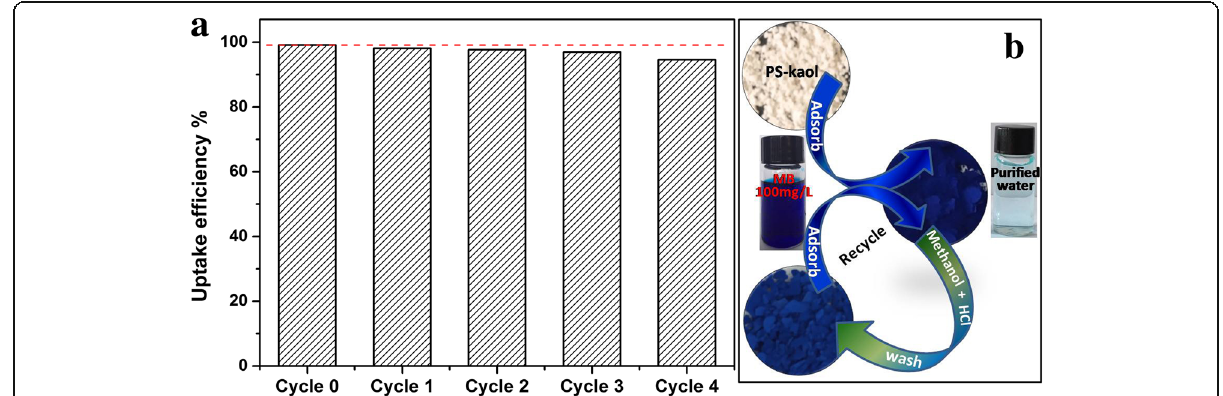
Fig. 6 a Different reusability cycles of PS-Kaol for removed MB. b Schematic image of the application and regeneration of PS-Kaol for water